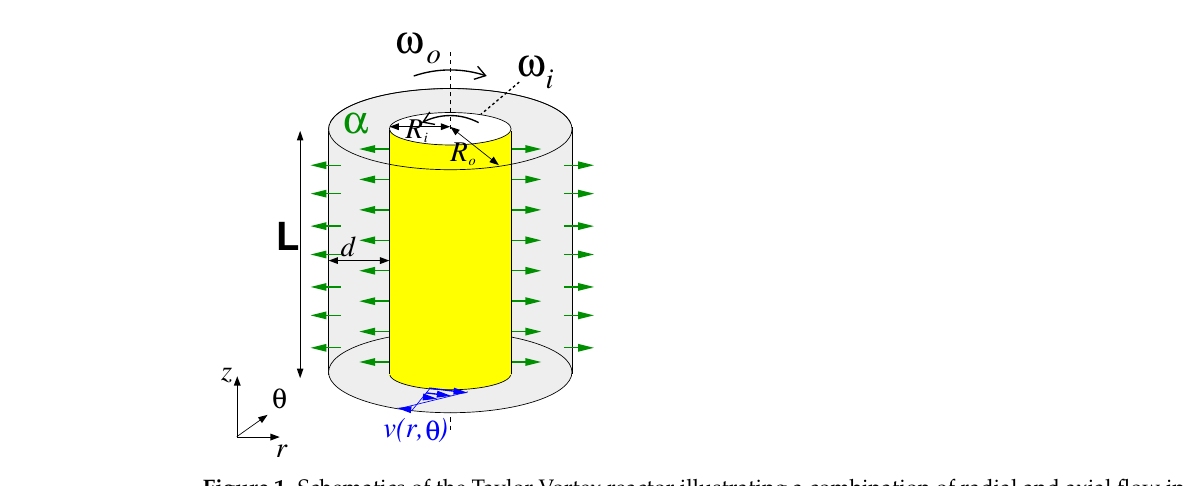
Figure 1. Schematics of the Taylor Vortex reactor illustrating a combination of radial and axial flow in counter-rotating configuration including sketch of laminar velocity profile v ( r , θ ) (not to scale). The radial flow can be directed outward ( α > O ) (illustrated), or inward ( α < O ) . The axial imposed mass flux Re is considered positive from bottom to